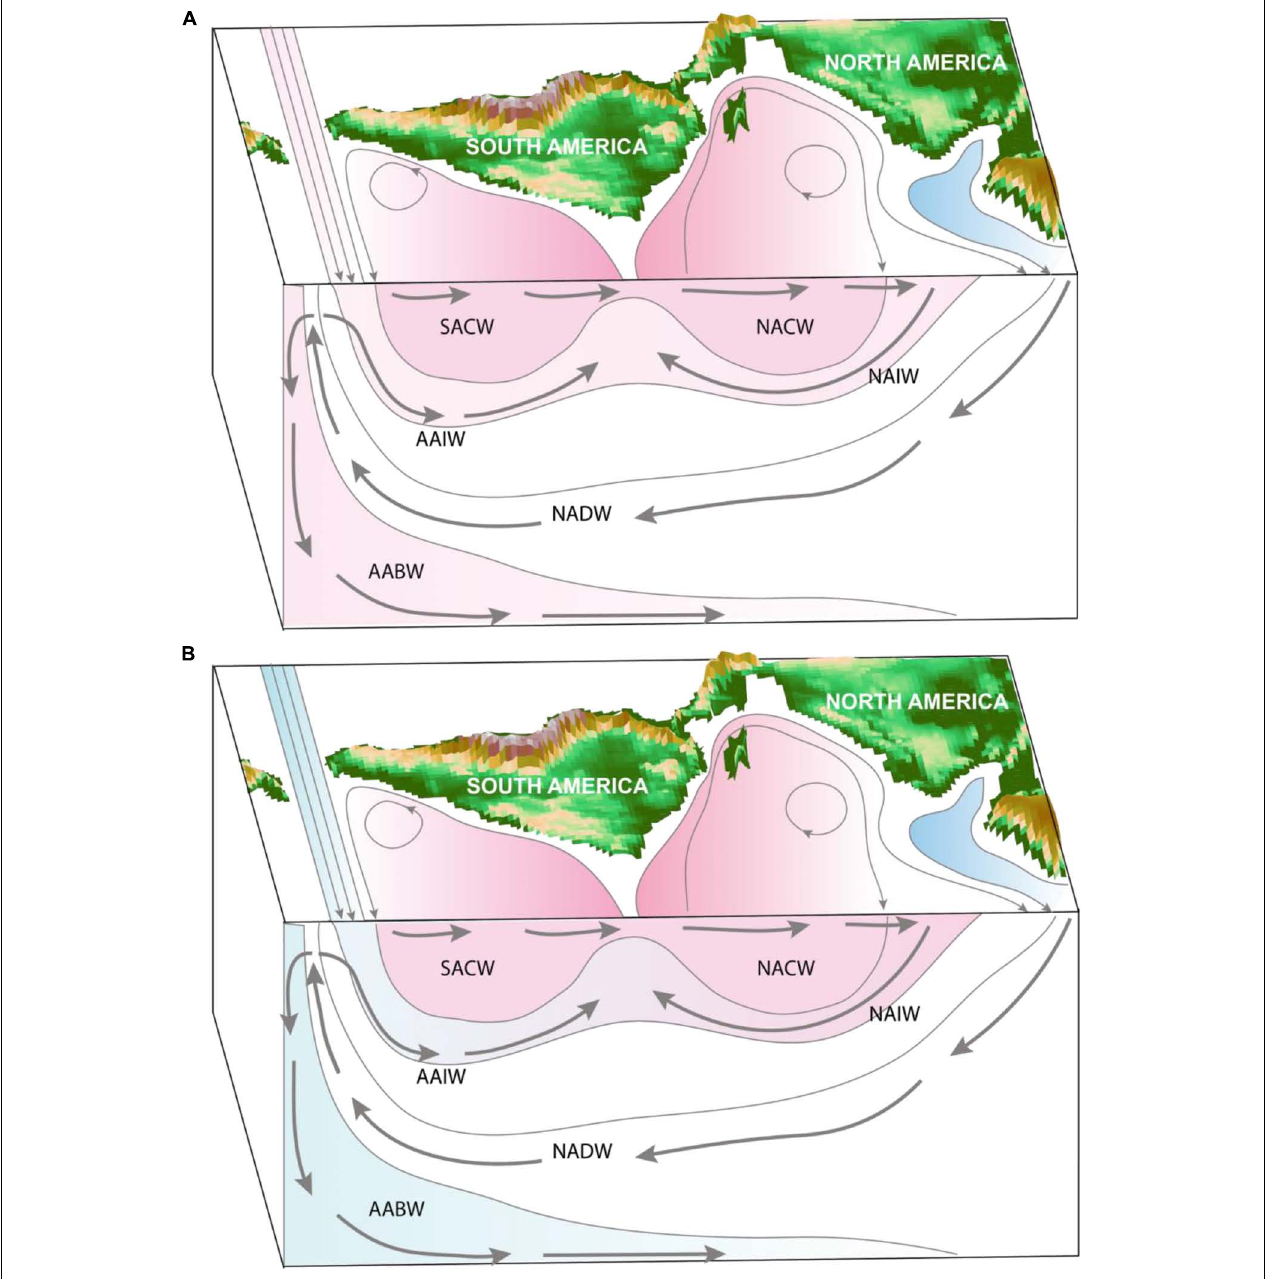
FIGURE 5 | Schematic showing temperature (A) and salinity (B) trends in different layers of the Atlantic Ocean. The layers are defined as main water-masses of the Atlantic Ocean. From the upper layers down to the ocean bottom: South Atlantic Central Water (SACW), North Atlantic Central Water (NACW), Antarctic Intermediate Water (AAIW), North Atlantic Intermediate Water (NACW), North Atlantic Deep Water (NADW), and Antarctic Bottom Water (AABW). Gray arrows show the main overturning pathways in the basin, and the black contours show a vertical slice of the vertical and meridional water masses distribution in terms of potential density. The color shading corresponds to: warming/saltier in red, cooling/freshening in blue, and white where no clear trends are